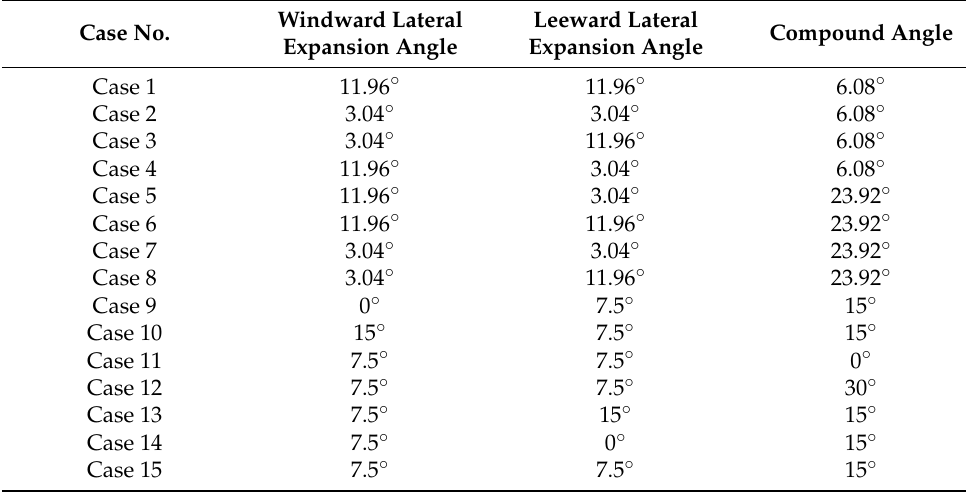
Table 2. Test matrix obtained by using the central composite design method. Case